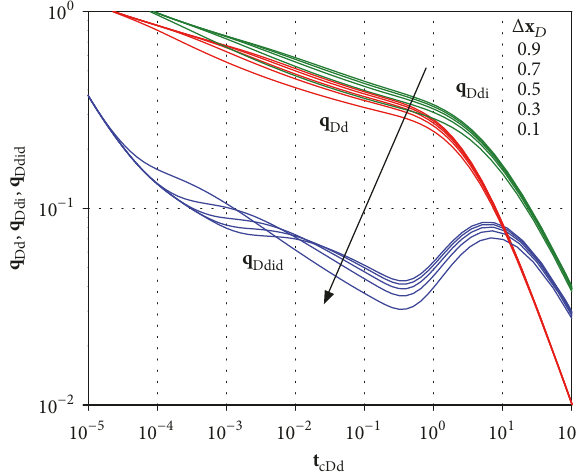
Figure 4: The effect of rate distribution on type curves.